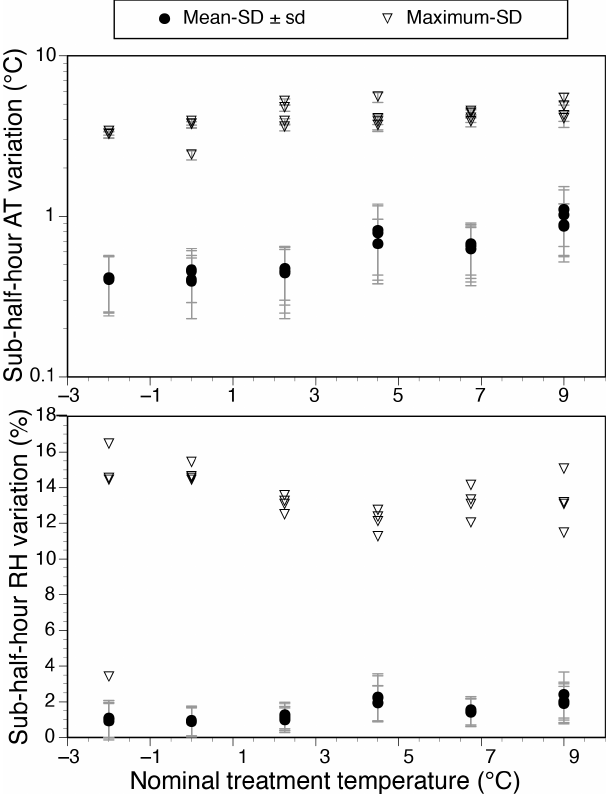
Figure 7. Sub-half-hour variation of air temperature (upper graph) and relative humidity (lower graph) data expressed as the standard deviation (SD or sd) of 1min observations within a half-hourly mea- surement period. Plotted data are the mean SD ± sd and maximum SD for half-hourly temperature and relative humidity data over the whole-ecosystem-warming period of observations reported in this paper for two replicate sensors in each treatment enclosure or plot. The − 2 and 0 ◦ C treatments in this graph represent unchambered ambient and no-energy-added control enclosures respectively.